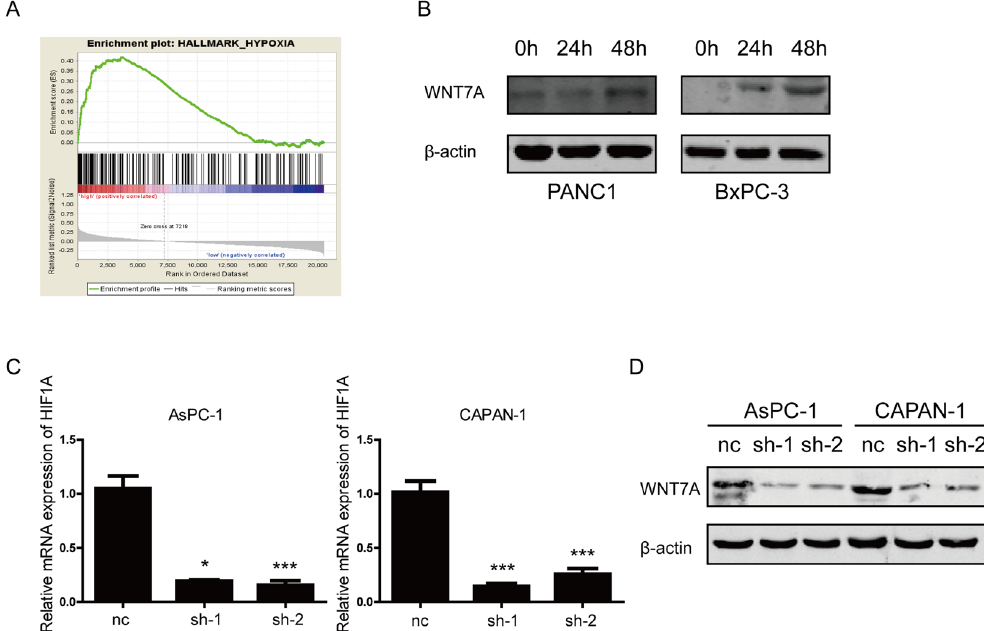
Figure 7. The expression of WNT7A is up-regulated in hypoxia condition. ( A ) GSEA showed the relationship between WNT7A expression and gene set of hallmark hypoxia. ( B ) The protein expression levels of WNT7A in PDAC cell lines cultured in hypoxia for different duration were detected by western blot. ( C ) The knockdown efficiency of HIF1 α in PDAC cell lines transfected with interfere plasmid were deteremined by qRT-PCR. ( D ) The effect of of HIF1 α knockdown on expression of WNT7A in two PDAC cell cultured in hypoxia condition were detected by Western